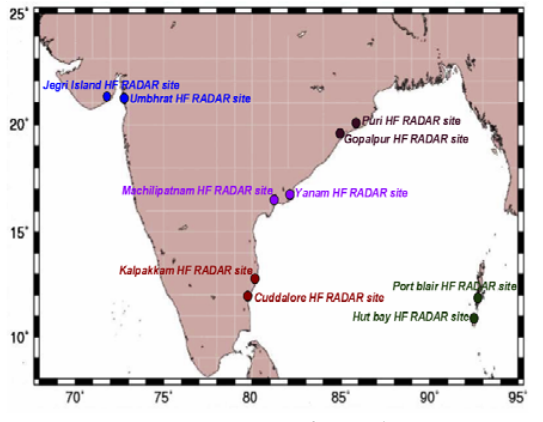
Figure 1. Locations of HF Radars HF Radar data i.e. total current vector file in ascii format has